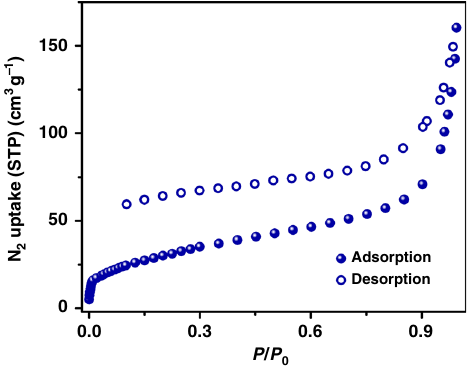
Fig. 3 N 2 sorption isotherms of PTC-1(2H) at 77 K. Source data are provided as a Source Data fi